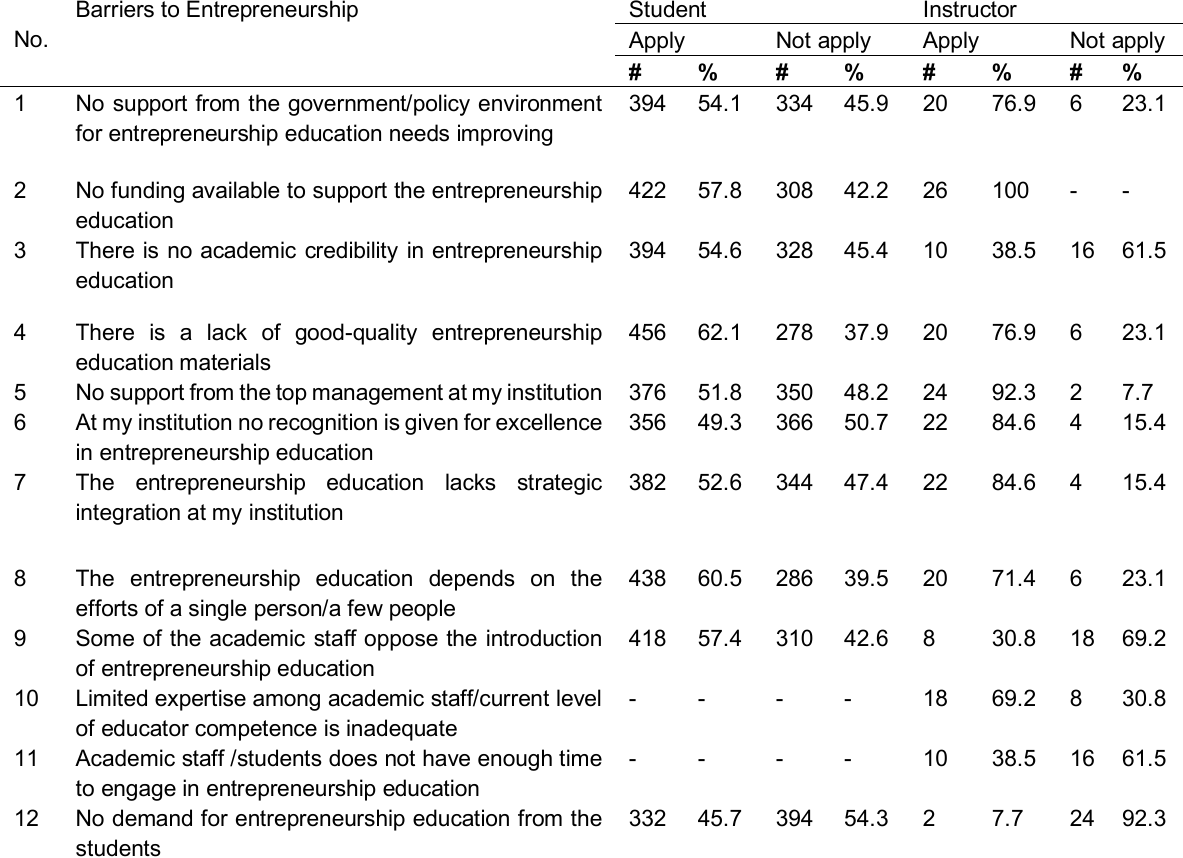
Table 6: The barriers to entrepreneurship